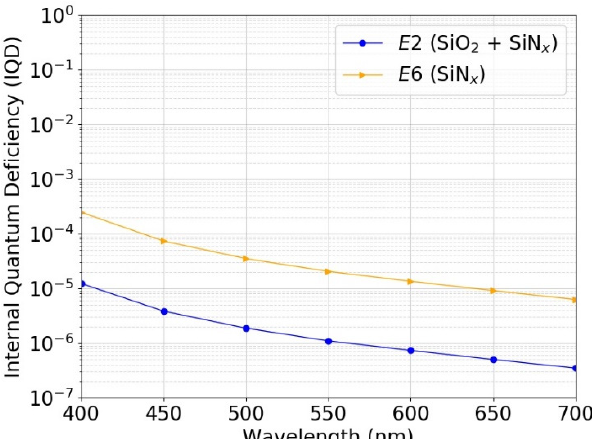
Figure 13. Simulated IQD as a function of wavelength for p-type inversion-layer photodiode that would be fabricated with passivation E2 (6 nm SiO 2 + 65 nm SiN x ) and E6 (65 nm SiN x ) as de- scribed in Table 1. The simulations were performed at a reverse bias voltage of 5